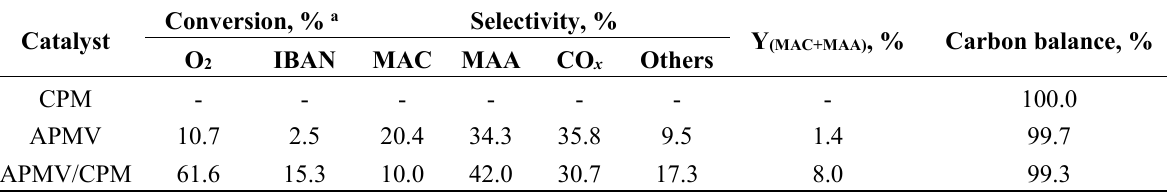
Table 1. Catalytic performances for selective oxidation of isobutane over the different samples.